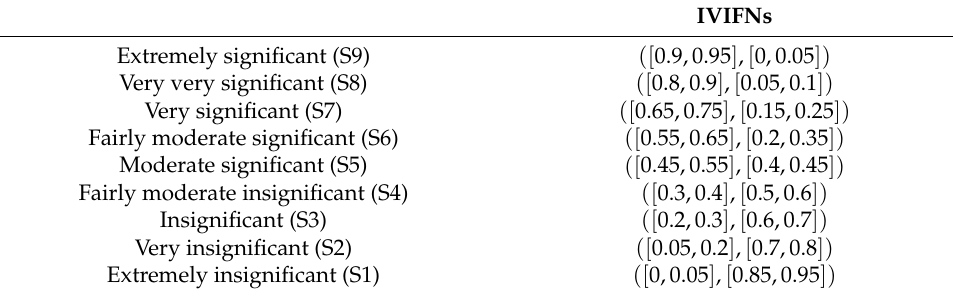
Table 3. The relative importance of performance indicators.